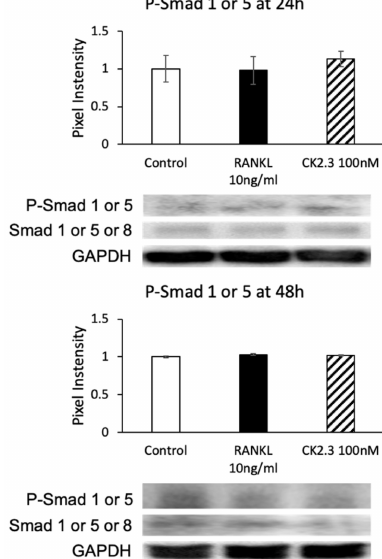
Figure 8. CK2.3 did not mediate the SMAD canonical pathway downstream of the BMP signaling pathway. The phosphorylation of Smad1 or 5 was not a ff ected by CK2.3 after either 24 h or 48 h of stimulation in RAW264.7